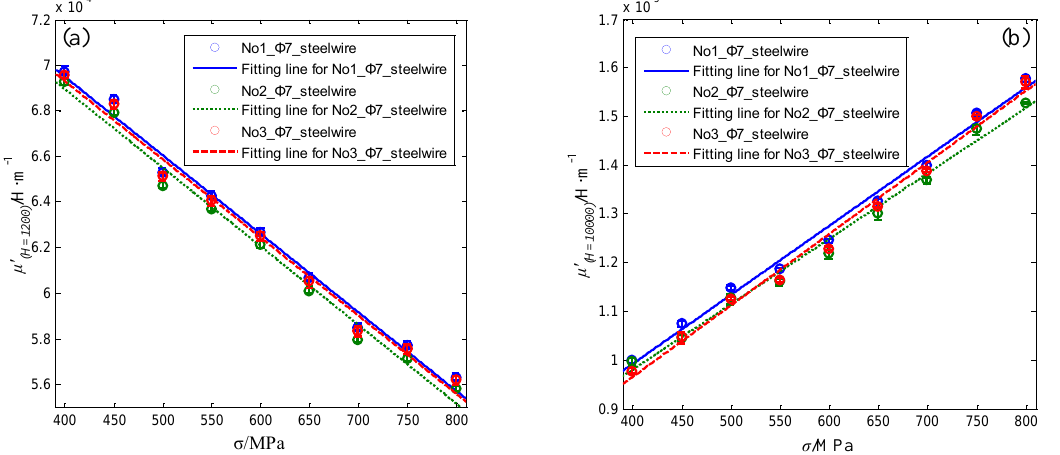
Figure 18. The relationship with the axial stress in the three Φ7 steel wire of differential permeability at working points H = 1200 A/m ( a ) and H = 10,000 A/m ( b ).